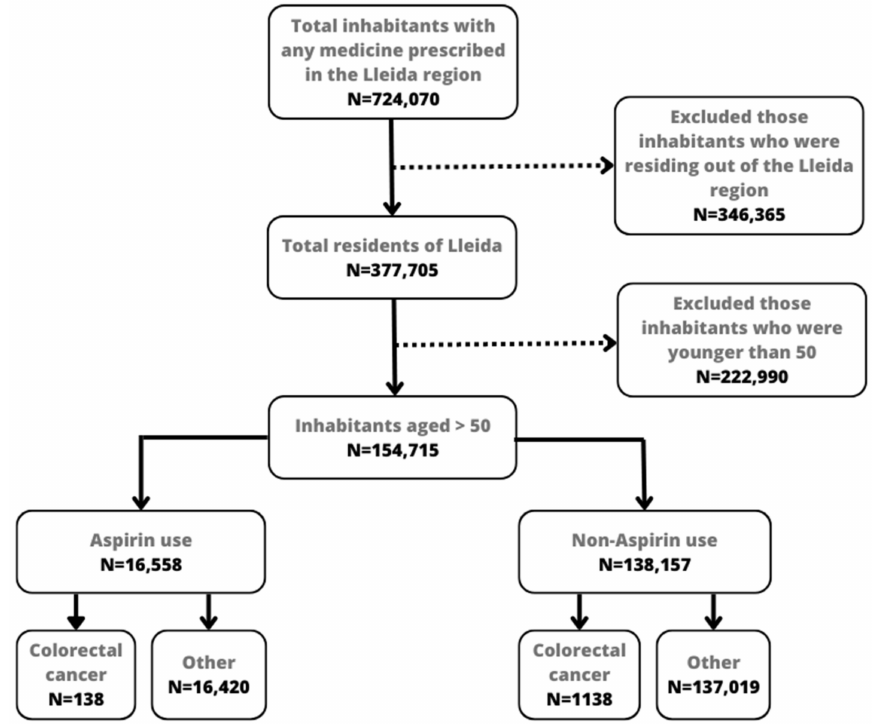
Figure 1. Flowchart of subjects included for the